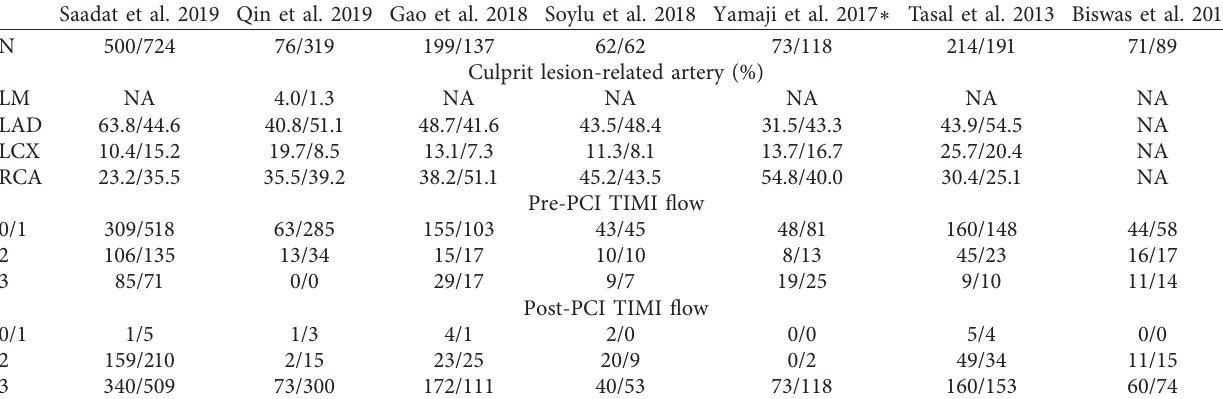
Table 2: Procedural characteristics of studies